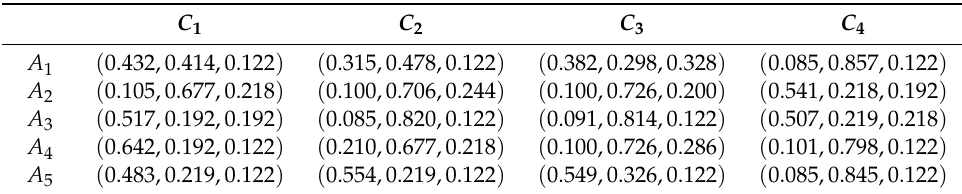
Table 5. The collective decision matrix given by the q - RPFDWG operator.